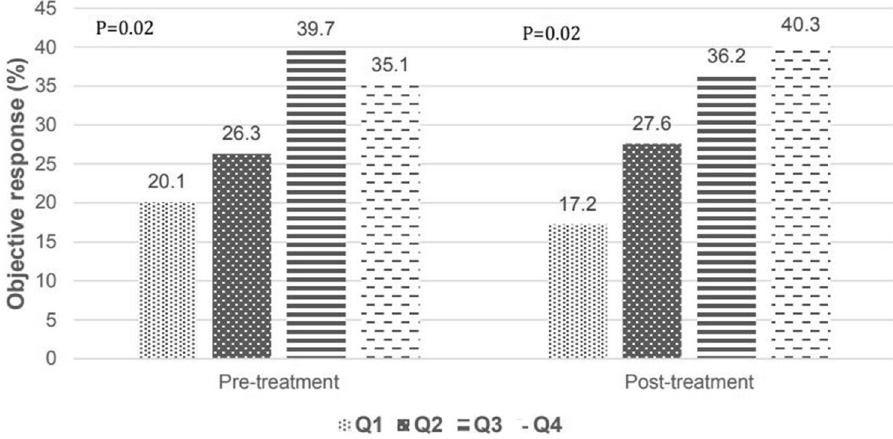
Figure 2. Tumor response rate according to pre- and post-treatment PLC.